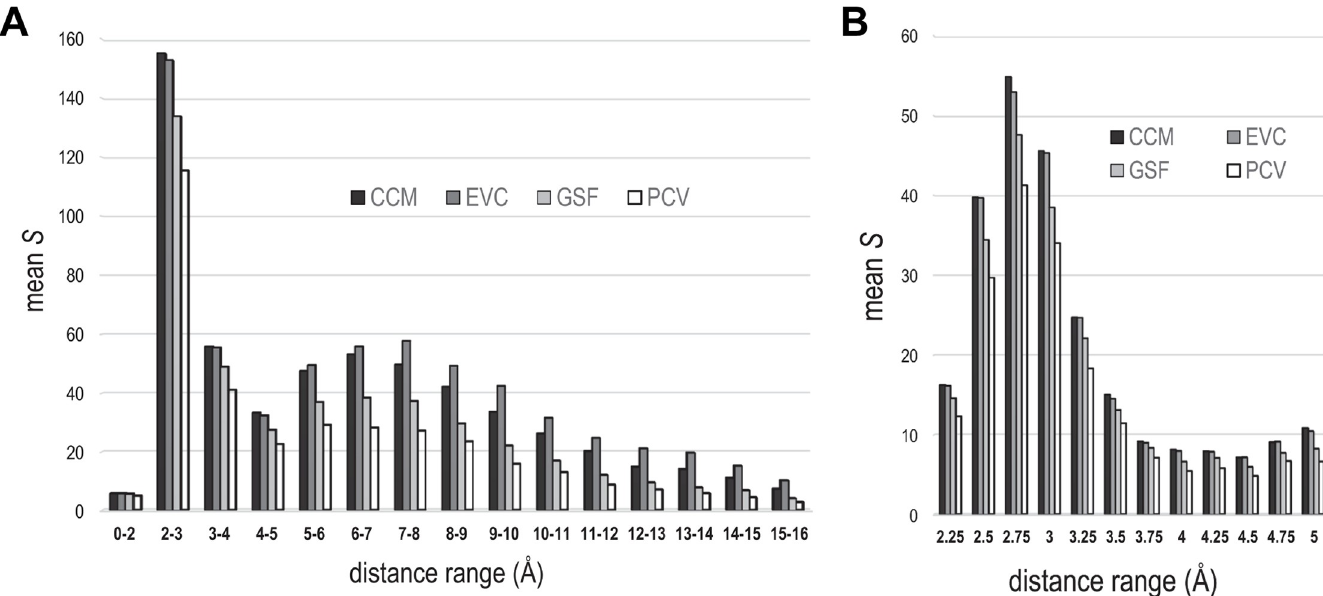
Fig 2. S as a function of 3D distance ranges defining distinguished residue pairs. See discussion in text. A . The s -scores obtained for distance ranges spanning zero to 16 Å . Column pairs corresponding to residue-to-residue distances below the indicated range were excluded from the analysis. B . Detailed plot of the span 2 to 5 Å . Each distance range covers 0.25 Å and is labeled by its upper